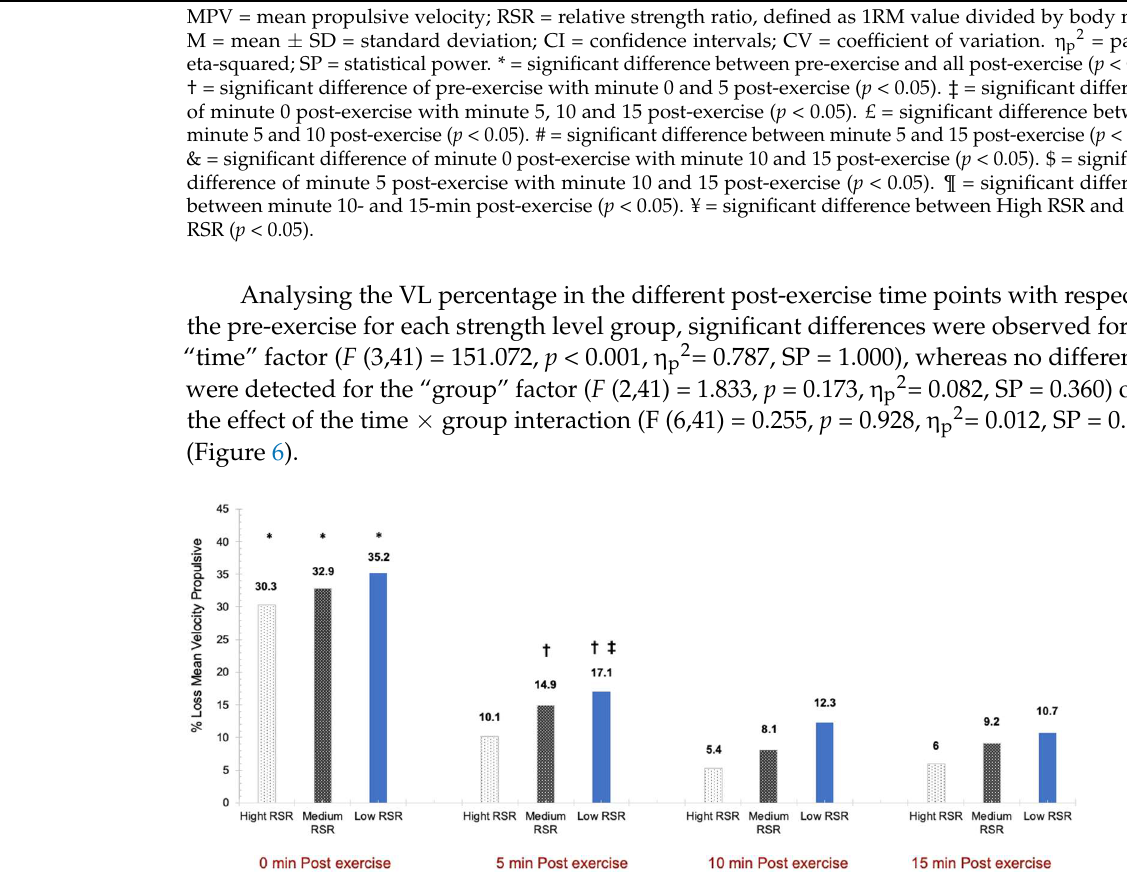
MPV = mean propulsive velocity; RSR = relative strength ratio, defined as 1RM value divided by body mass; M = mean ± SD = standard deviation; CI = confidence intervals; CV = coefficient of variation. η p2 = partial eta-squared; SP = statistical power. * = significant difference between pre-exercise and all post-exercise ( p < 0.05). † = significant difference of pre-exercise with minute 0 and 5 post-exercise ( p < 0.05). ‡ = significant difference of minute 0 post-exercise with minute 5, 10 and 15 post-exercise ( p < 0.05). £ = significant difference between minute 5 and 10 post-exercise ( p < 0.05). # = significant difference between minute 5 and 15 post-exercise ( p < 0.05). & = significant difference of minute 0 post-exercise with minute 10 and 15 post-exercise ( p < 0.05). $ = significant difference of minute 5 post-exercise with minute 10 and 15 post-exercise ( p < 0.05). ¶ = significant difference be- tween minute 10- and 15-min post-exercise ( p < 0.05). ¥ = significant difference between High RSR